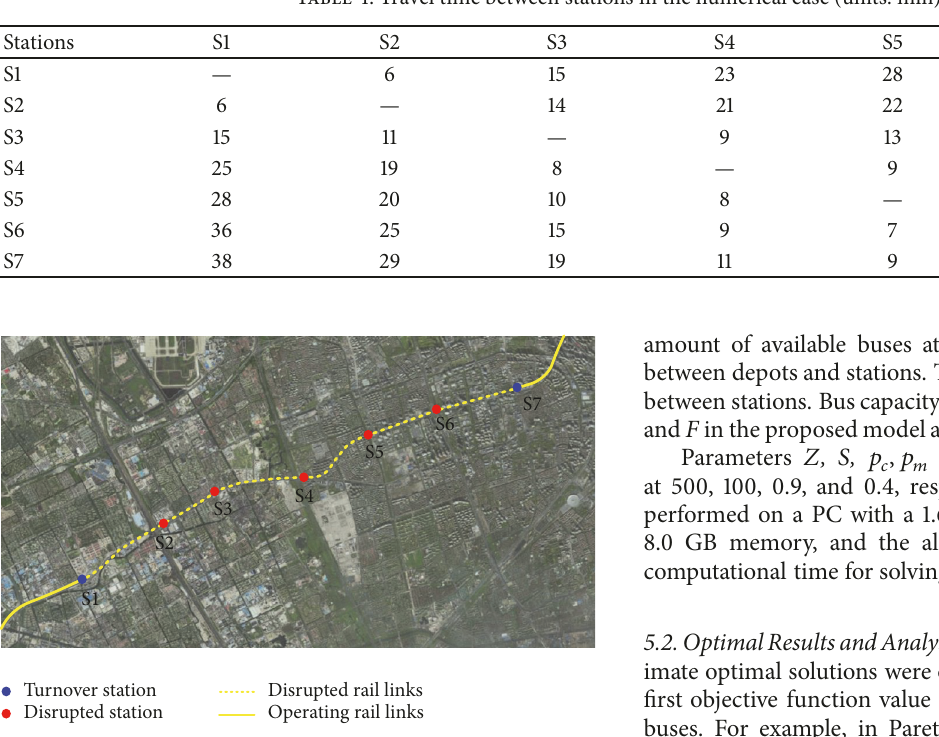
Figure 7: Disrupted scenario of the metro line in the case